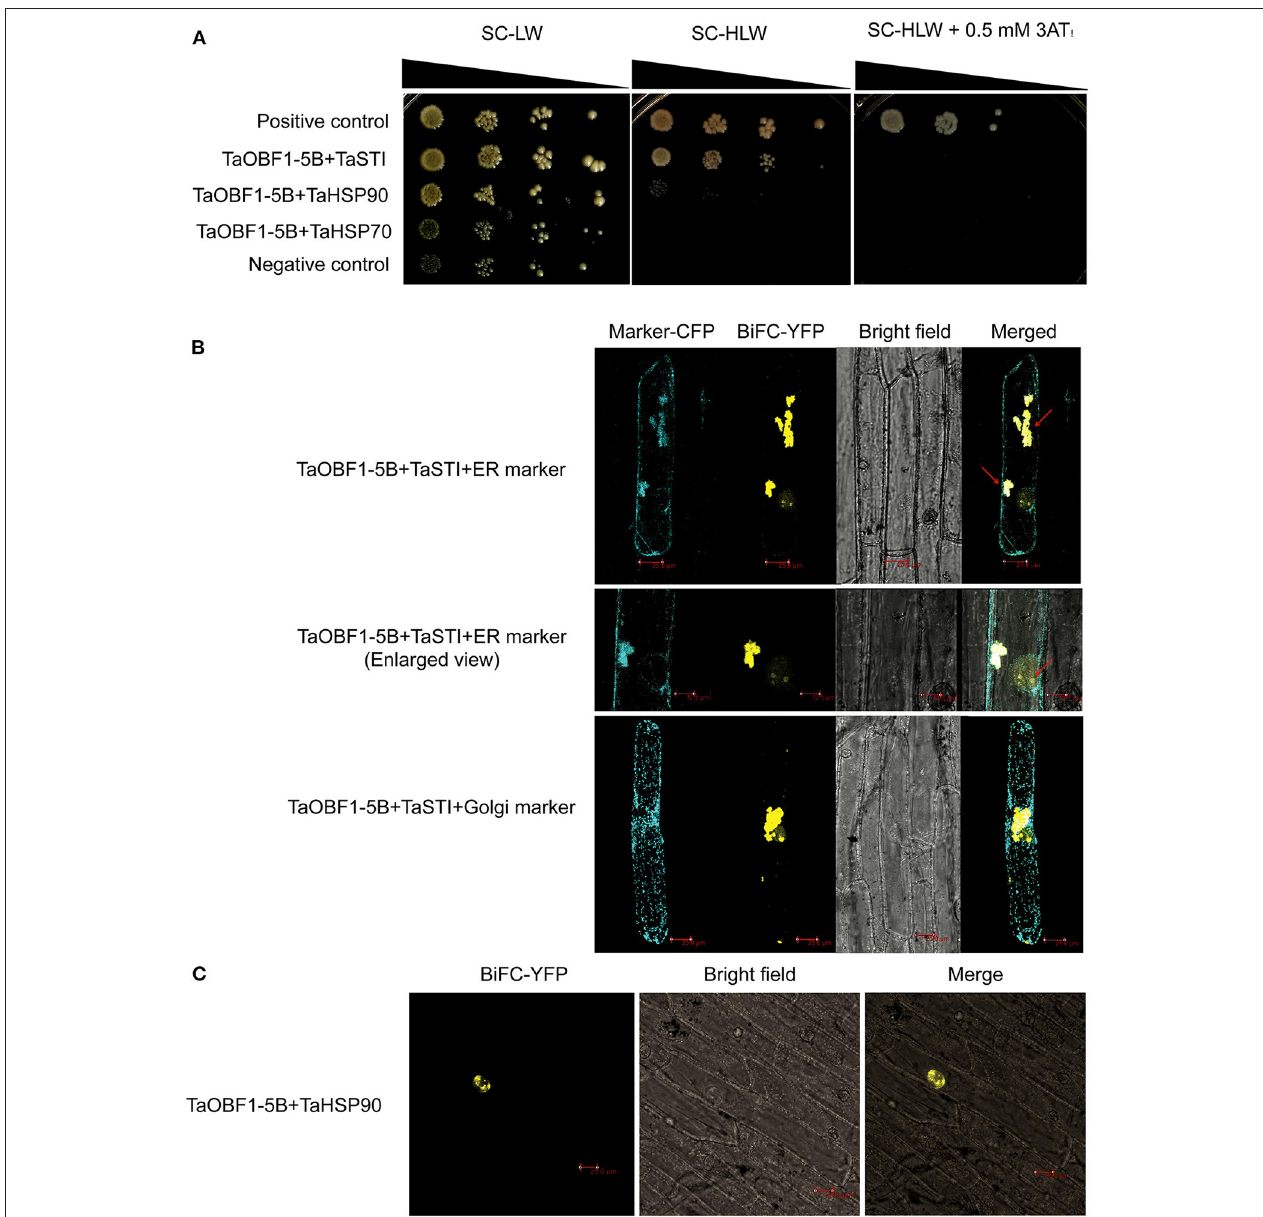
FIGURE 5 | Interaction of TaOBF1-5B with TaSTI and TaHSP90. (A) The yeast-two-hybrid assay was performed to check the interaction of TaOBF1-5B with TaSTI, TaHSP90, and TaHSP70 proteins. The growth of co-transformed yeast cells was analyzed on SD/-Leu/-Trp (-LW) medium and on SD/-Leu/-Trp/-His (-HLW) medium. Drop assay was performed on media lacking histidine, leucine, and tryptophan (-HLW) along with 0.5mM 3-aminotriazole (3AT). Pair of plasmids pGBKT7-53 and pGADT7-T were used as positive control, and pGBKT7-Lam and pGADT7-T were used as the negative control. (B) BiFC assay showing the interaction of TaOBF1-5B with TaSTI-2A in the nucleolus and ER in onion epidermal cells. The localization of the BiFC signal was comparable with the ER marker localization. Red arrows indicate the interaction occurring in the ER and in the nucleolus [ER (endoplasmic reticulum); Scale bar 25 µ m]. (C) BiFC assay showing the interaction of TaOBF1-5B with TaHSP-90 in the nucleus in onion epidermal cells (scale bar 25 µ